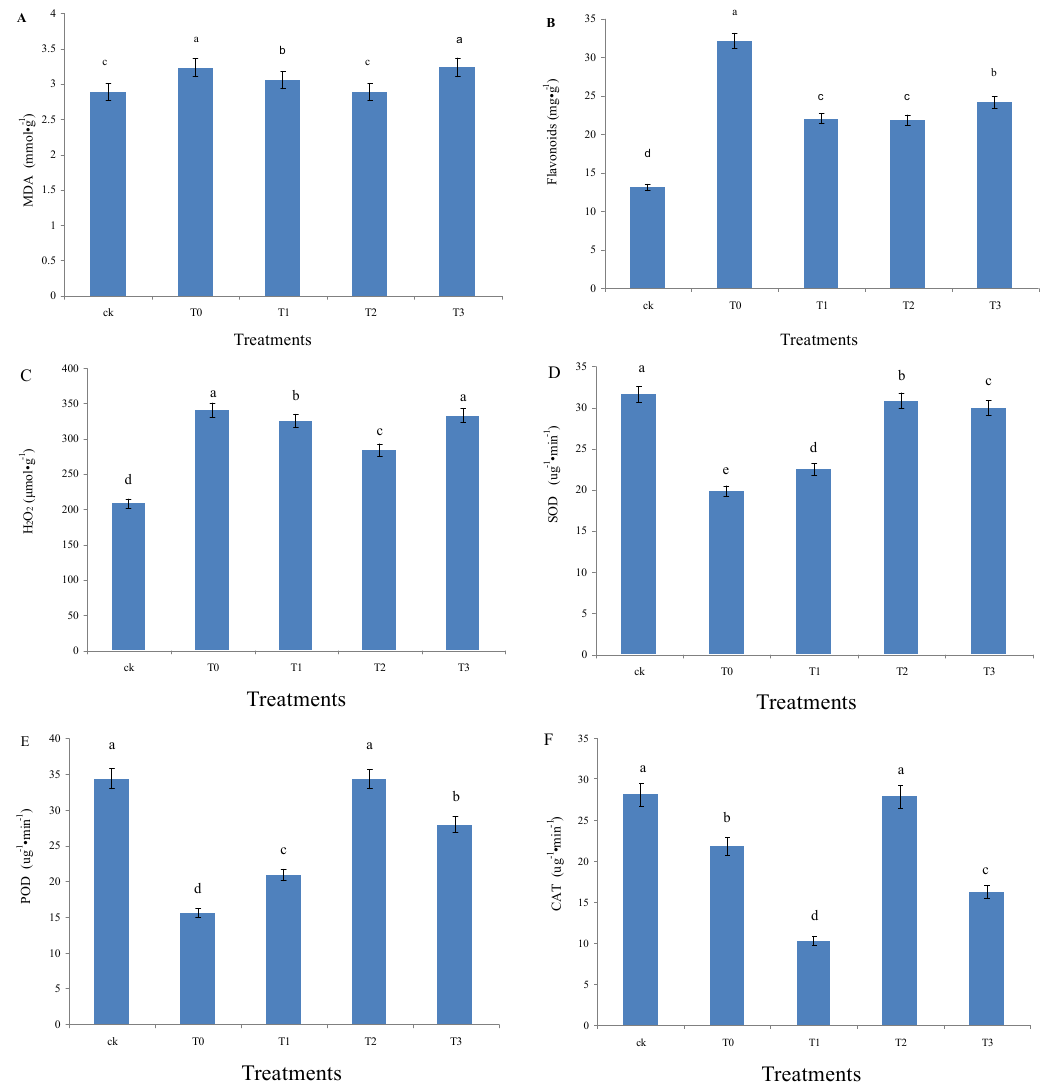
Figure 1. Effect of the NO donor on MDA ( A ), Flavonoids ( B ). H 2 O 2 ( C ), SOD ( D ), POD ( E ) and CAT ( F ) in Larix gmelinii seedlings under enhanced UV-B radiation. Different lower case letters within a line indicate a significant difference ( p < 0.05) between different treatments. The values are the means ± SD of three replicate samples per treatment. CK: natural UV-B radiation and normal water status; T 0 : enhanced UV-B radiation and normal water status; T 1 , T 2 , T 3 : the combination group (supplementary UV-B radiation with the nitric oxide donor sodium nitroprusside (SNP) at different concentrations, i.e., 0.01 mM (T 1 ), 0.1 mM (T 2 ) and 0.5 mM (T 3 ).